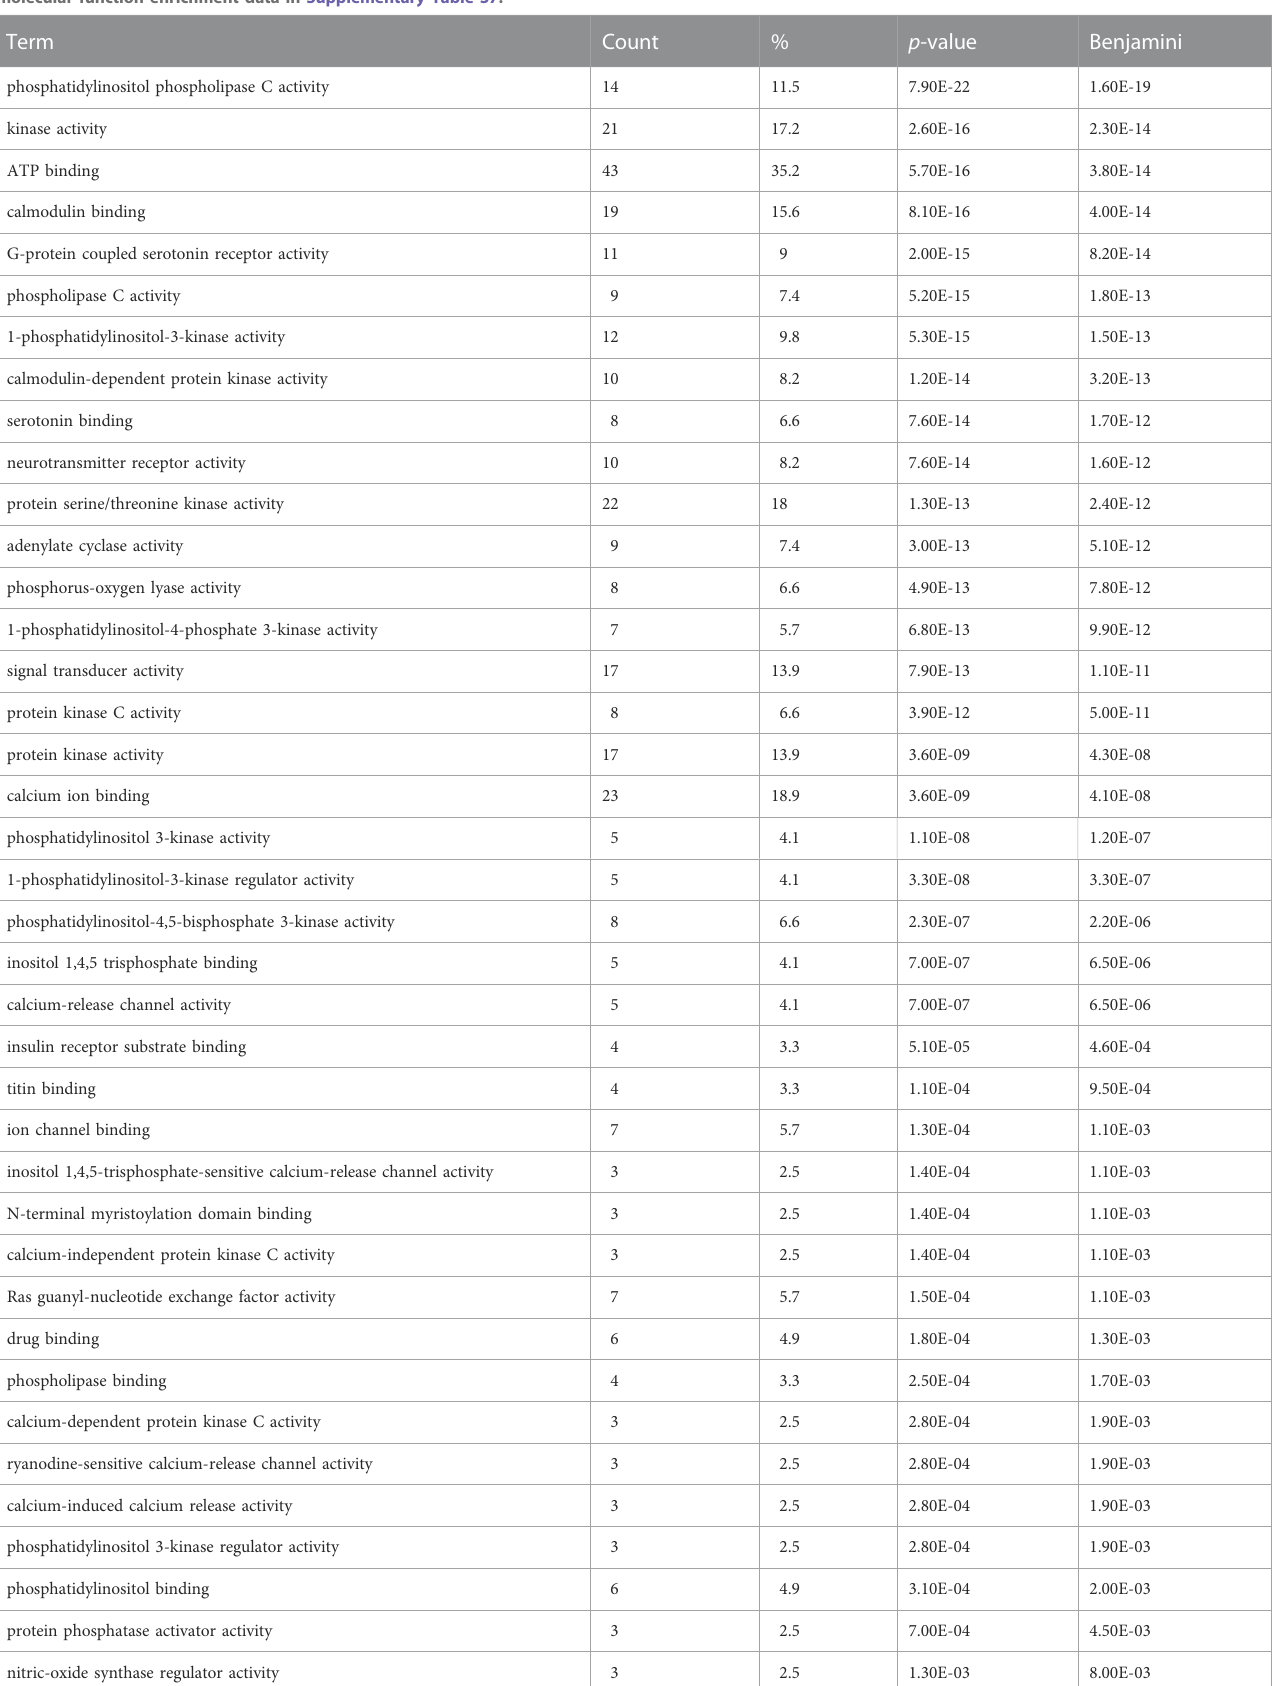
TABLE3GeneOntologyEnrichment – MolecularFunction(Mostsigni fi cantresults).Geneontologymolecularfunctionenrichmentanalysisperformedonthesetof125 shrew ( Cryptotis parva ) candidate genes for emesis. Term corresponds to the gene ontology term, count indicates how many genes within the 125 candidate gene set contained the molecular function annotation, % is the percent of genes containing the annotation within the emesis candidate gene set, p -value is the uncorrected p - value, Benjamini corresponds to the false discovery rate associated with type I errors in null hypothesis in cases of multiple testing. Complete set of gene ontology molecular function enrichment data in Supplementary Table